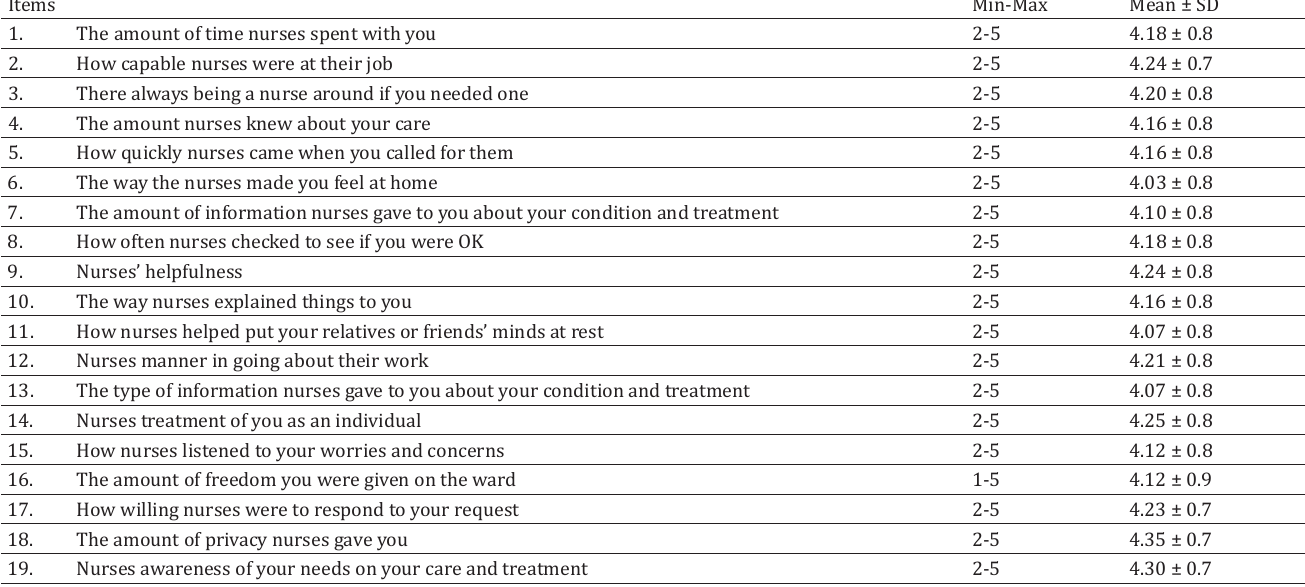
Patients' responses to the NSNS (n =